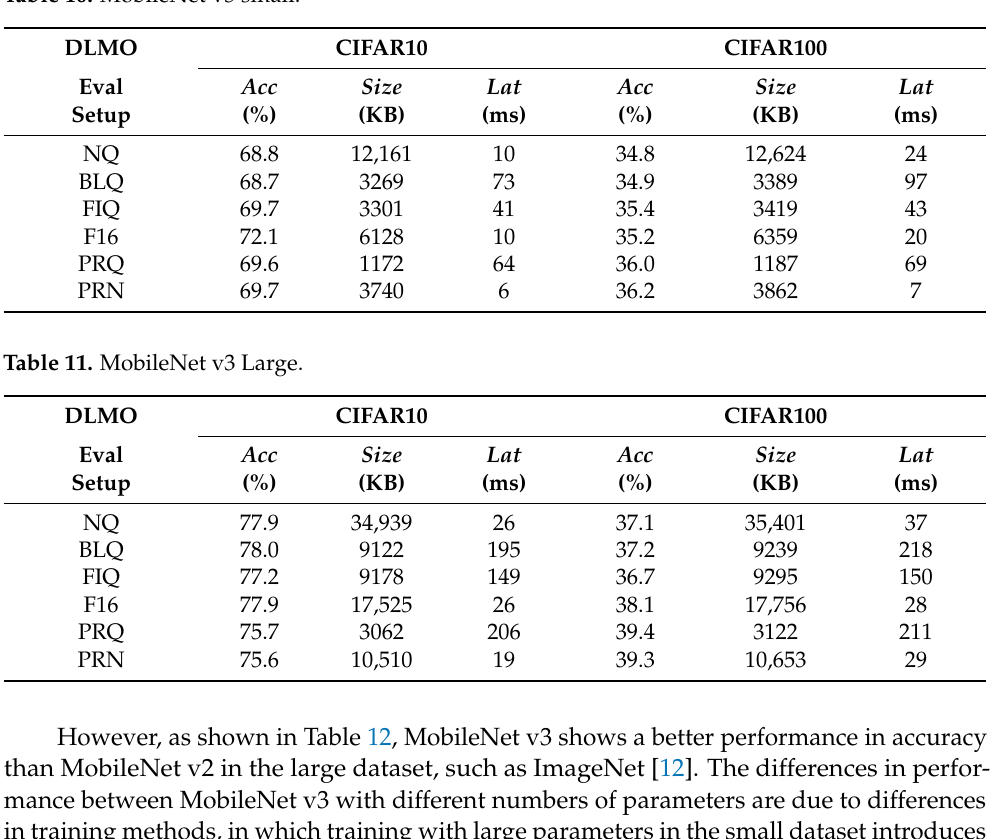
Table 10. MobileNet v3 small.